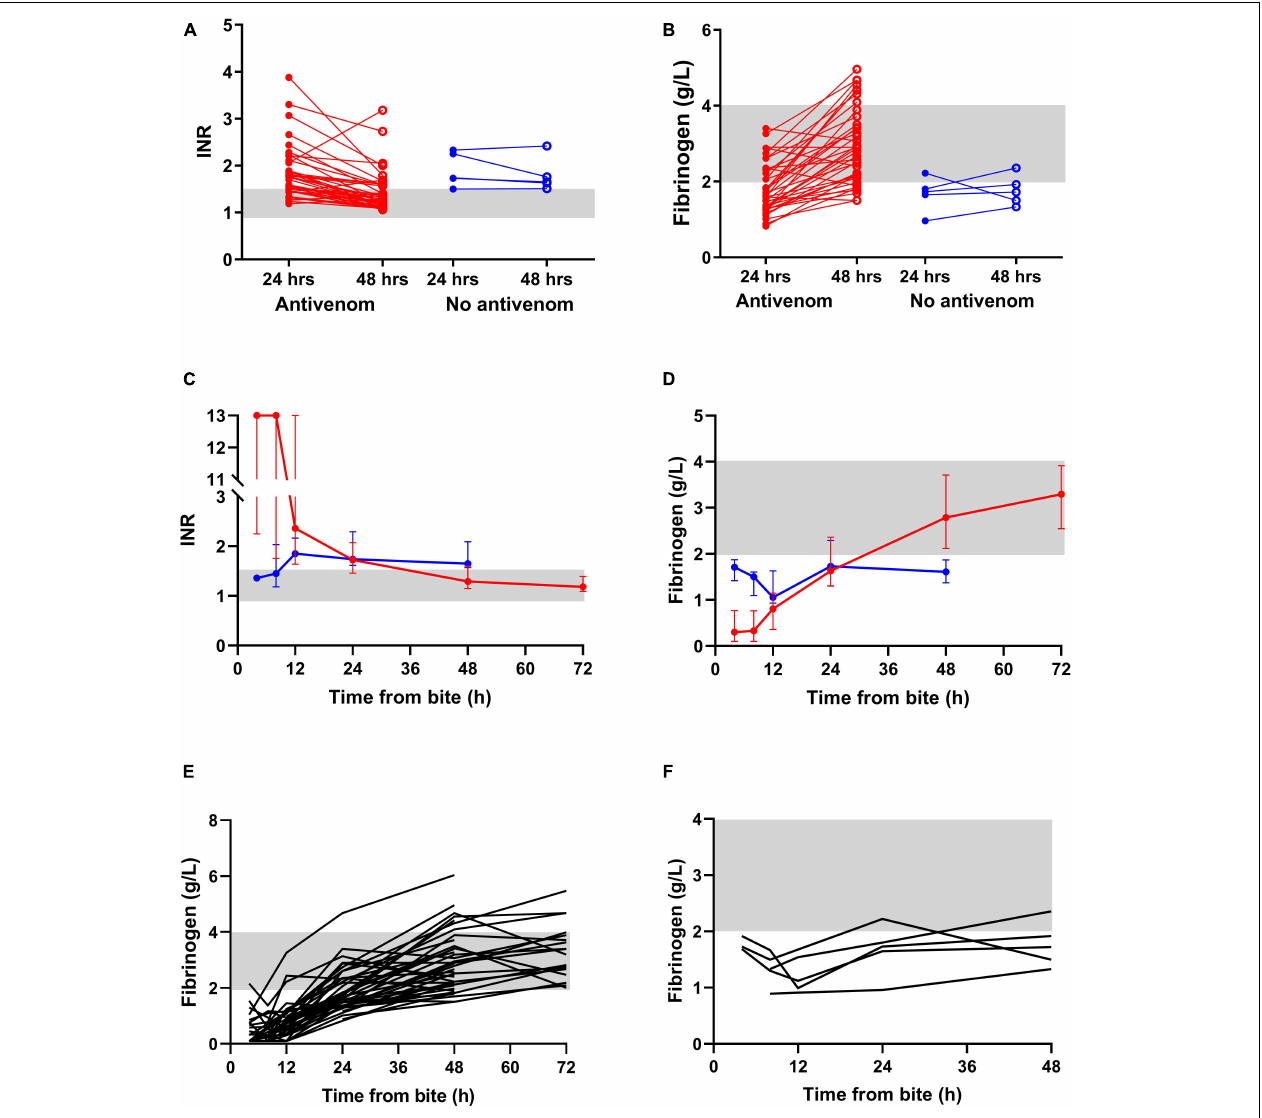
FIGURE 2 | Change of the INR and fibrinogen concentrations of antivenom (red symbols) and no antivenom (blue symbols) groups: change of INR (A) and fibrinogen (B) between 24 and 48 h from the bite in antivenom and no antivenom groups (note both INR and fibrinogen significantly improve between 24 and 48 h period in the antivenom group as opposed to no improvement in no antivenom group, p ≤ 0.0001, paired t test); (C) Time-related change of the median and Interquartile range of INR (C) and fibrinogen (D) of antivenom and no antivenom groups; noodle plots showing the time-related change of plasma fibrinogen concentrations of all patients of antivenom (E) and no antivenom (F) groups. The shaded areas represent the normal